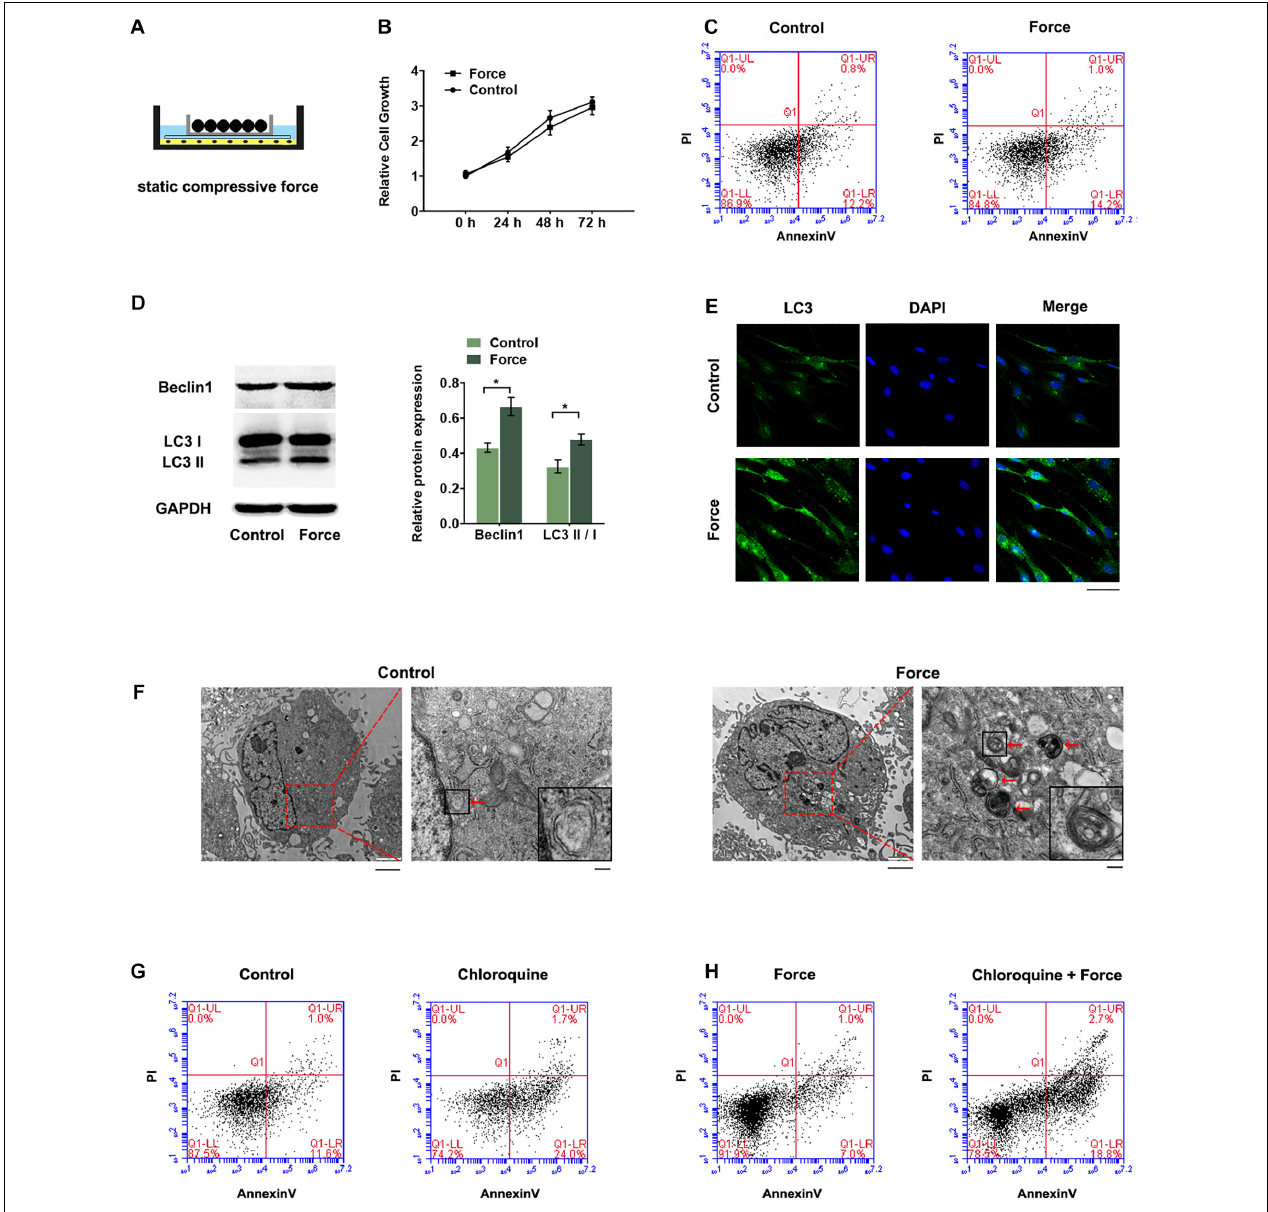
FIGURE 1 | Autophagy was increased in PDLSCs under compressive force. Cells were subjected to static compressive force for 12 h. (A) Schematic diagram of compressive force applied. (B) Relative cell growth of PDLSCs with or without compressive force. (C) Apoptotic cells were monitored with FACS after Annexin V and PI staining. (D) Western blot analyses of Beclin1 and LC3II/LC3I. Histograms show the quantification of the band intensities. (E) Images of LC3 immunofluorescence staining. Scale bar: 50 µ m. (F) Ultrastructural features assessed by electron microscopy in the control group and force group (arrows point to the autophagosomes or autolysosomes). Scale bar: 2 µ m (left) and 500 nm (right). (G) Flow cytometry of Annexin V-FITC/PI staining in PDLSCs with or without chloroquine treatment (10 µ M). (H) Flow cytometry of Annexin V-FITC/PI staining in PDLSCs under compressive force with or without chloroquine pre-treatment. Data are presented as the mean ± SD ( n = 3, * p <